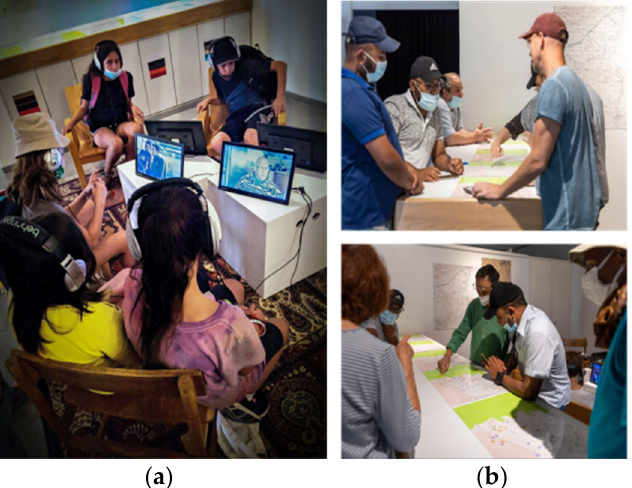
Figure 11. Scenes from “ Common Views: Sourcing Water ” Exhibition, ACAC, Arad, 2020, curated by Irit Carmon Popper. ( a ) “Dreaming Room”—a special space in the center of the exhibition presenting the various theoretical and historical materials of the exhibition, where the public is invited to learn and contemplate. ( b ) Artists Dan Farberoff (top) and David Behar Perahia (bottom) with local Bedouins from Al-Baqi’a discussing a map of the options to draw the future ‘cistern trail’—a tourist walking trail that will connect the Jewish town of Arad and the Bedouin settlements of Al-Baqi’a region. Photographed by Dan Farberoff. Images courtesy of the artist.